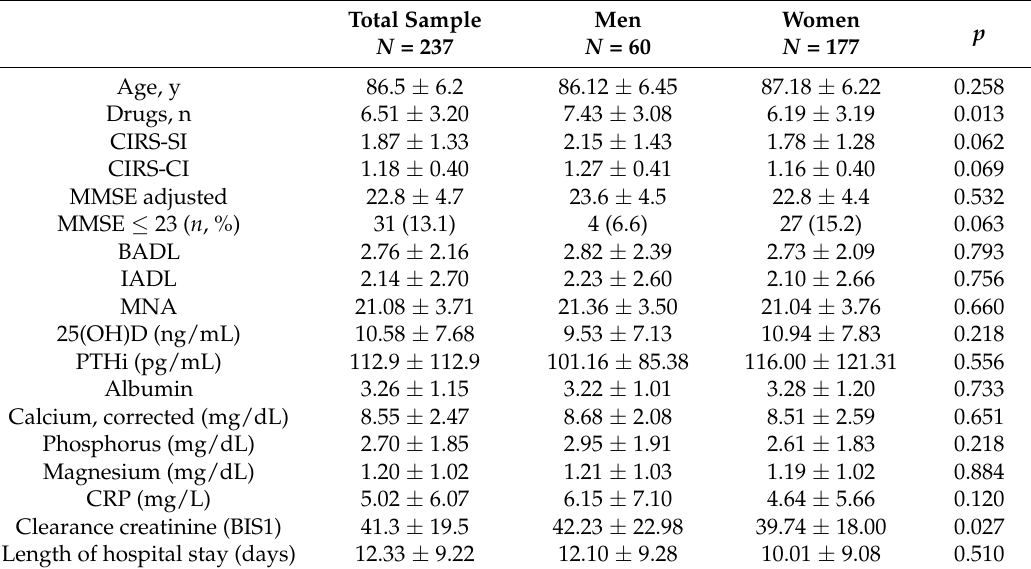
Table 1. Baseline population sample characteristics ( n =